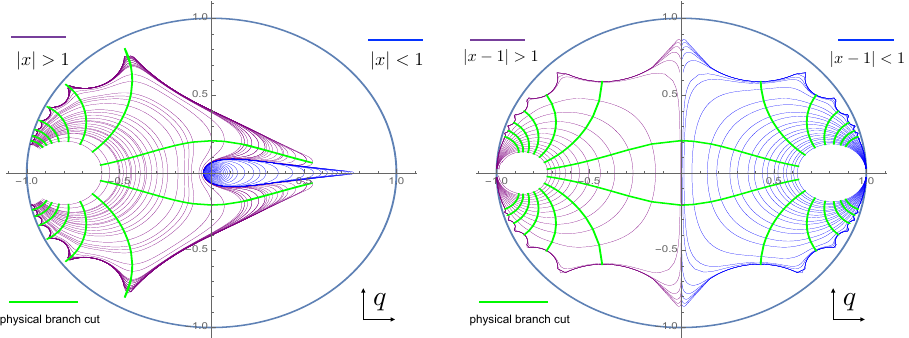
Figure 22 . Mapping between the q -plane and the (Lorentzian sheets of) x -plane. Left: contours of constant x circles on the q plane; right: contours of constant j j Green lines correspond to the physical branch-cuts from x = 1 to x = distinct Lorentzian sheets in the x -plane are mapped to disjoint regions in the q -plane bounded by the green